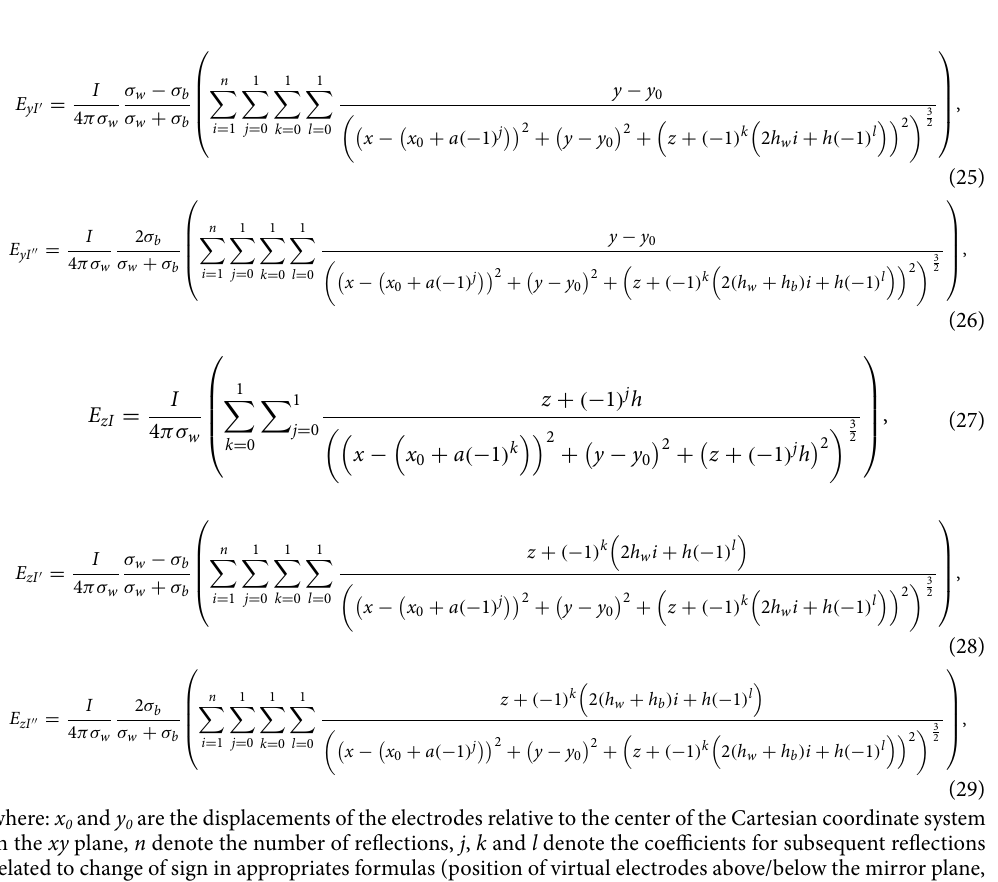
Figure 5. Case of two-layer